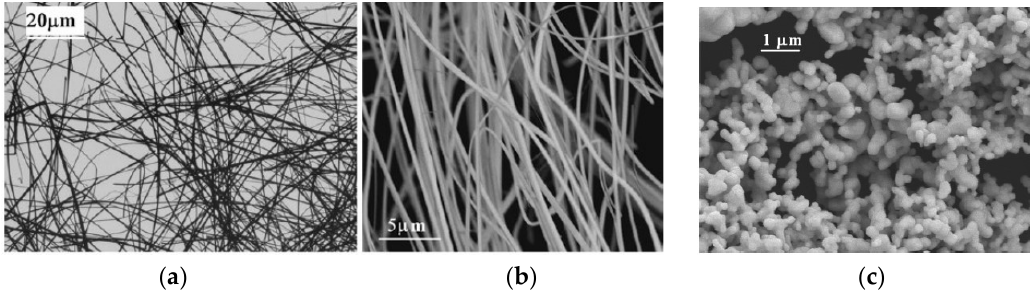
Figure 6. Structured nanomaterials used to prepare LCE-based composites. ( a ) TEM image of the MoO 3−x nanowires, and ( b ) SEM image of the MoO 3−x nanowires, revealing their electrical conductivity under 10-keV conditions. Adapted with permission from the authors of [61]. Copyright © 2018 Springer Nature. ( c ) A field-emission SEM picture of PbTiO 3 quasi-spherical nanoparticles with an average diameter of 100 nm. Adapted with permission from the authors of [60]. Copyright (2018) American Chemical Society.